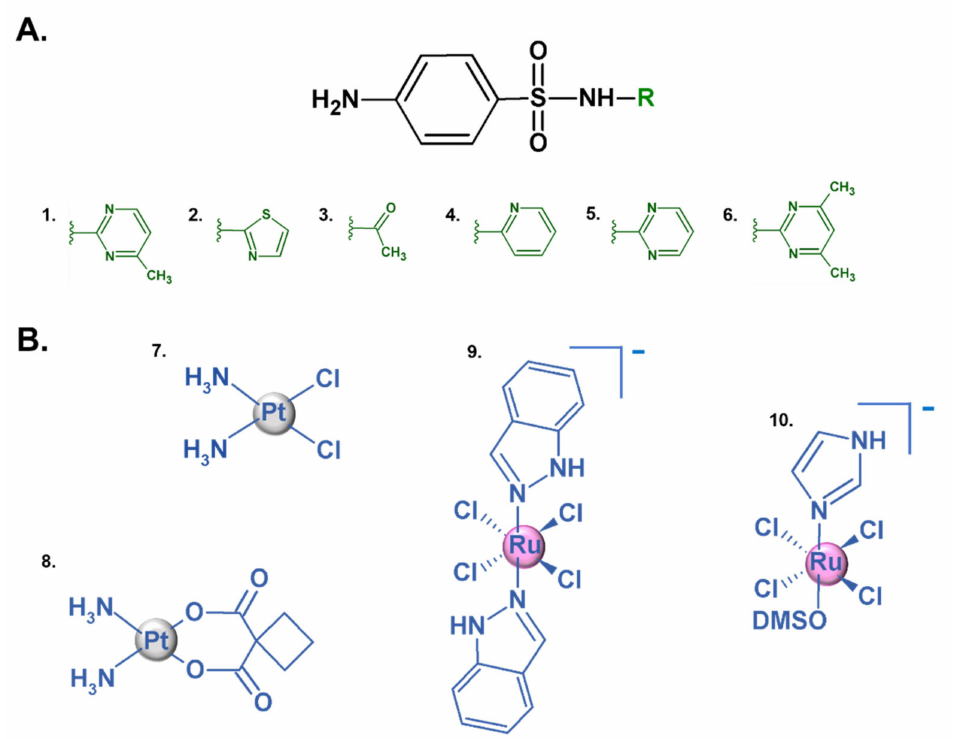
Figure 1. The general formula of sulfonamide-based antibacterial drugs and their examples: 1. sulfamerazine (SMZ), 2. sulfathiazole (STZ), 3. sulfacetamide, 4. sulfapyridine, 5. sulfadiazine, 6. sulfamethazine ( A ). Structures of the most well-known metal-containing drugs 7. cisplatin, 8. carboplatin, 9. NAMI-A, 10. KP1019 ( B